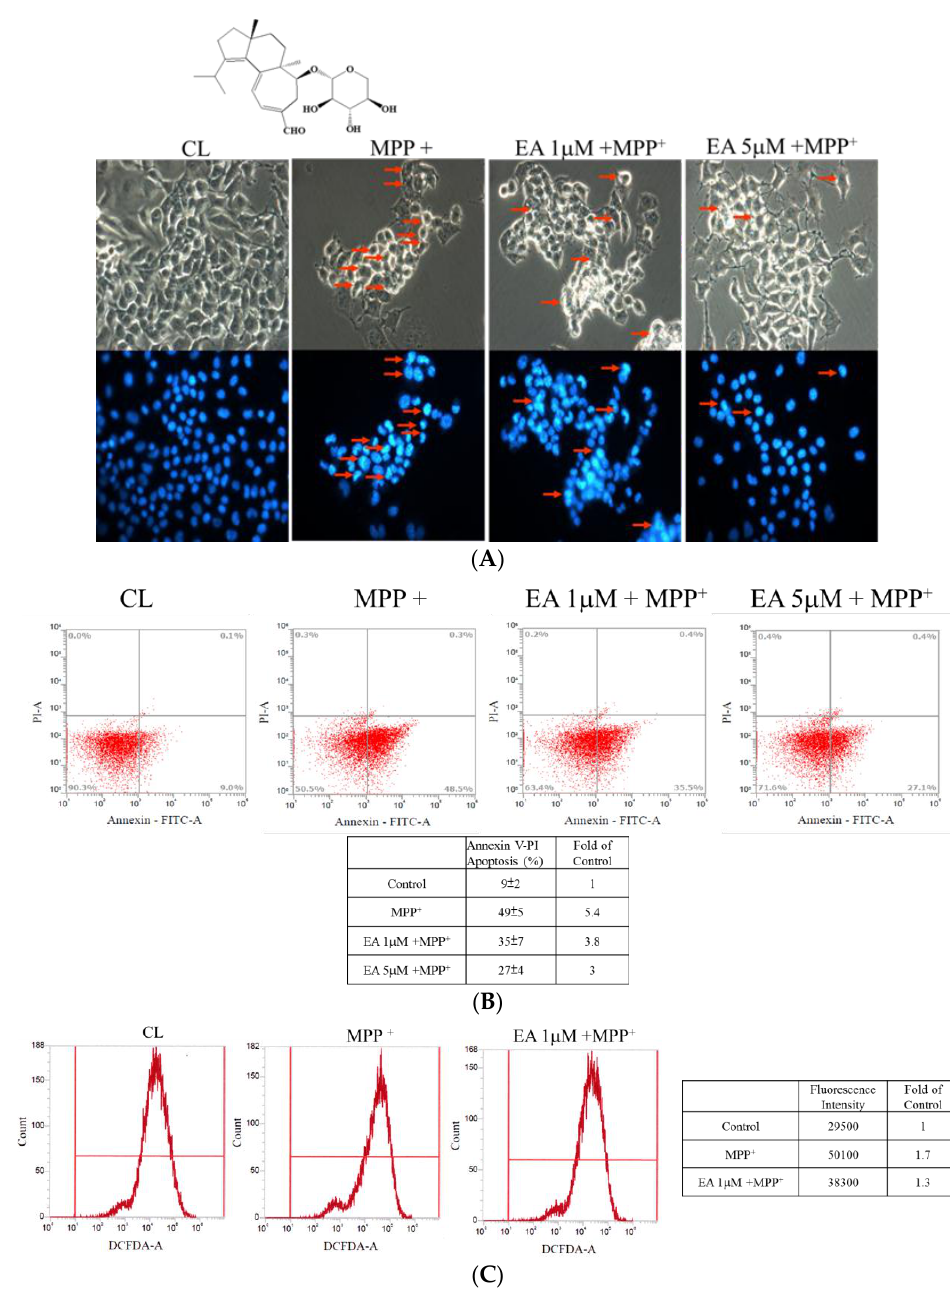
Figure 2. Erinacine A prevention of 1-methyl-4-phenylpyridinium (MPP + )-induced cell death and reactive oxygen species (ROS) generation of Neuro-2a (N2a) cells. ( A ) Cell apoptosis of the N2a cell line treated with 0.1% dimethyl sulfoxide (DMSO), MPP + , or MPP + and erinacine A (1 and 5 µM) at 24 h measured by DAPI staining under fluorescence microscopy. The red arrows indicate the condensed apoptotic cells with fragmented nuclei at a magnification of ×200. ( B ) Flow cytometry analysis of the N2a cell line treated with 0.1% DMSO, MPP + , or MPP + and erinacine A (1 and 5 µM) at 24 h stained by fluorescein isothiocyanate (FITC)-conjugated annexin V and propidium iodide (PI). The percentages of these treated cells with positive annexin V and/or PI and their changes (fold increase of untreated control) are shown in each quadrant. ( C ) After being incubated with H2DCFDA, the intracellular ROS of the N2a cell line treated with 0.1% DMSO, MPP + , or MPP + and erinacine A at 24 h was detected by FACS analysis. Typical FACS profiles for H2DCFDA in the cells under di ff erent treatments are shown in the upper panel; the fluorescence intensity of each treatment and their changes (fold increase of untreated control) are shown in the bottom